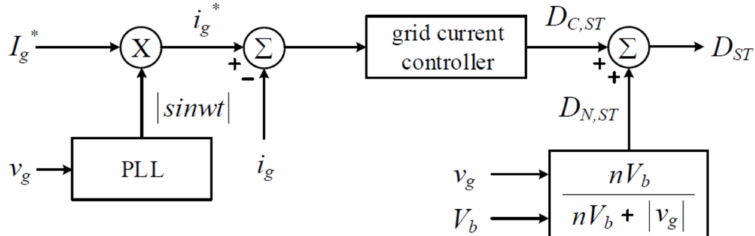
Figure 4. Bidirectional grid current control block diagram of the grid-tied zeta